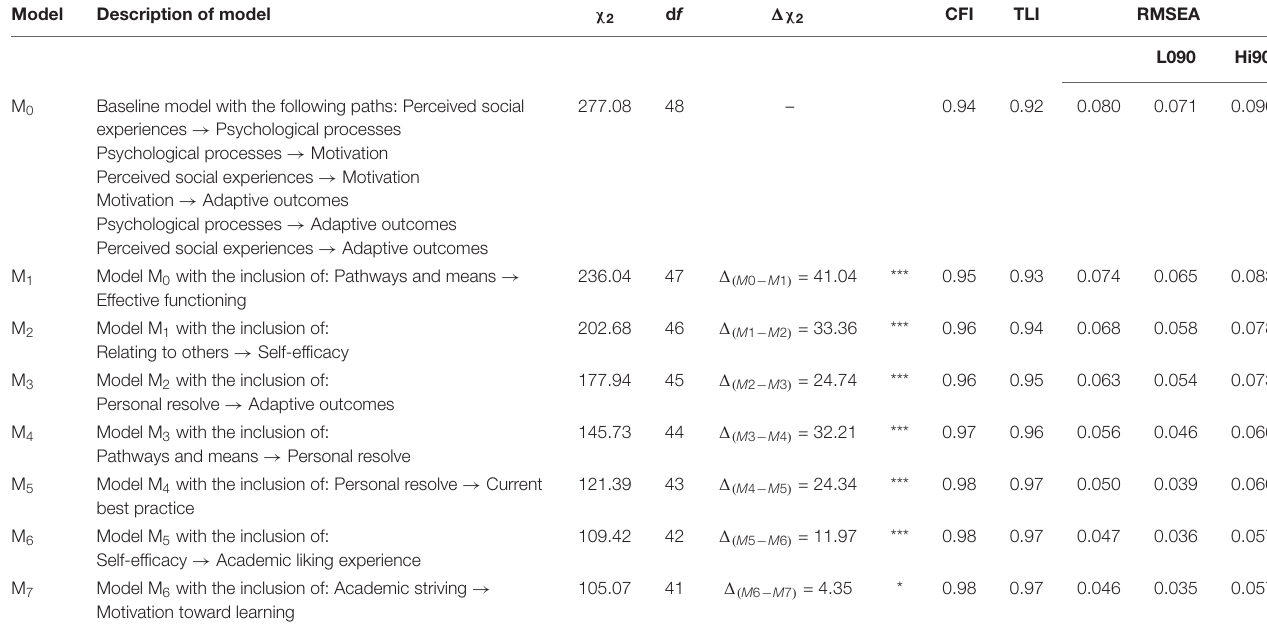
TABLE 5 | Summary of fit-index values for models tested. Model Description of